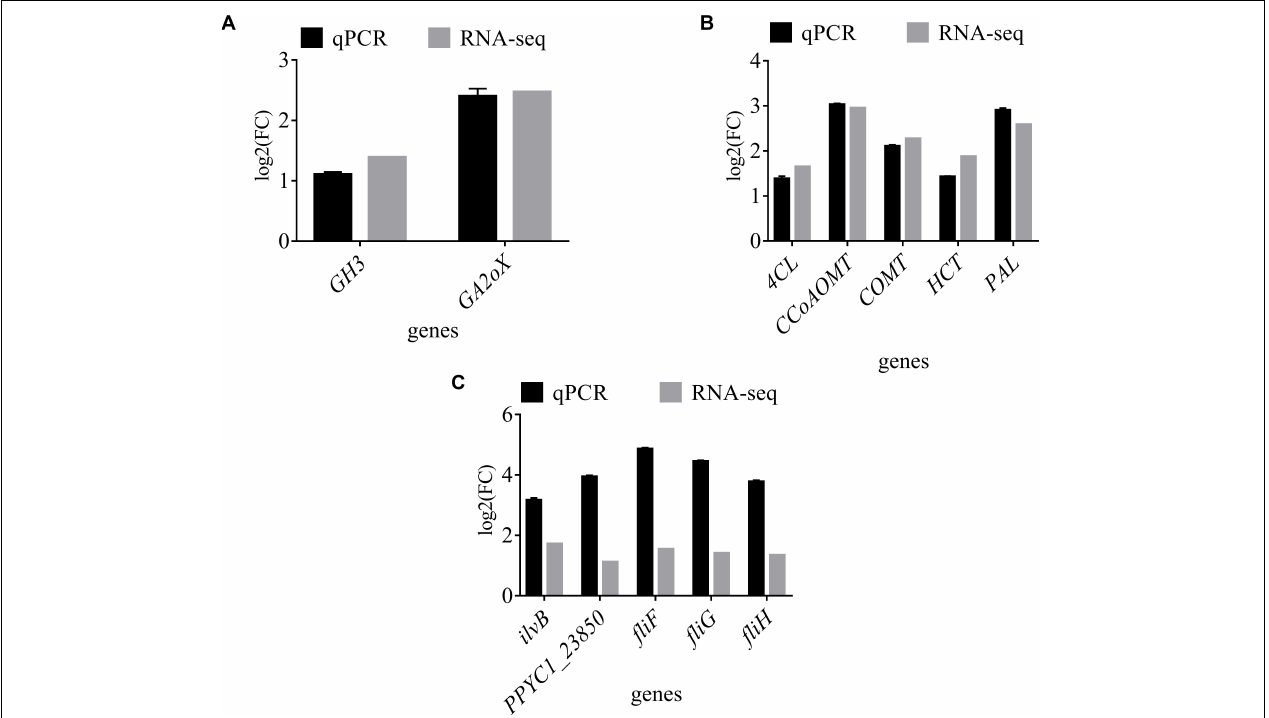
FIGURE 6 | RT-qPCR assay of genes in tobacco and YC0136. Fluorescence RT-qPCR to verify the accuracy of the transcriptome data. One microgram of purified total RNA was used as template for first-strand cDNA synthesis. Several genes from RNA-seq were selected for amplification by SYBR green RT-qPCR. The GAPDH gene of strain YC0136 and the actin gene of tobacco were selected as references. Relative expression levels were calculated using the delta-delta Ct method. (A) RT-qPCR results for genes related to plant hormone transduction in tobacco. (B) RT-qPCR results for genes related to phenylpropane compound metabolism in tobacco. (C) RT-qPCR results for genes in strain YC0136. Three biological replicates were carried out, and three technical replicates were performed. Error bars indicate the SD from the mean.